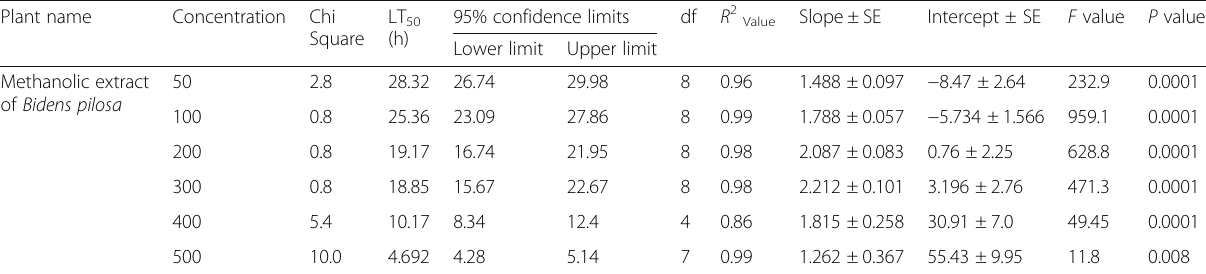
Table 9 Log probit and regression analysis of time dependent larvicidal efficacy of methanolic extract of B. pilosa at different concentrations against third instar larvae of C. quinquefasciatus Plant